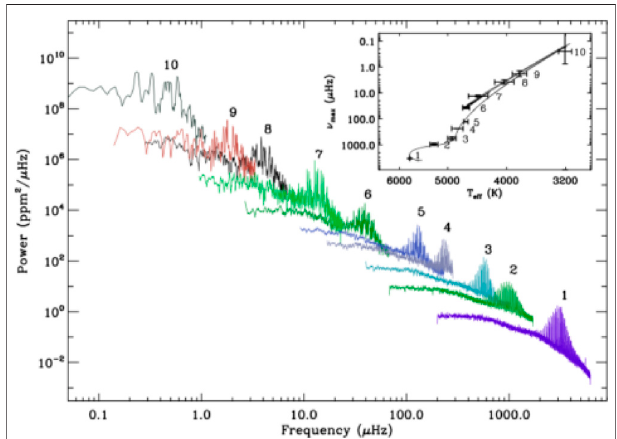
FIGURE 2 | Samples of power spectral density for Kepler solar-like oscillators at different evolutionary stages. The Sun ’ s spectrum is labeled #1 (purple). The inset shows model tracks of a 1 M ⊙ star and the corresponding power spectra labels approximately related to each evolutionary state. Figure from Garcia and Stello (Garcia and Stello,